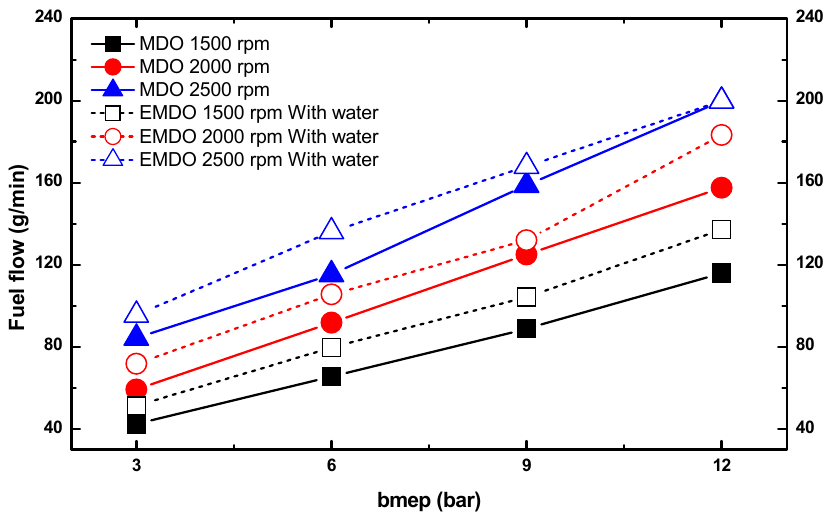
Figure 9. Fuel consumption with marine diesel oil (MDO) and emulsified MDO (EMDO) fuels according to rpm.